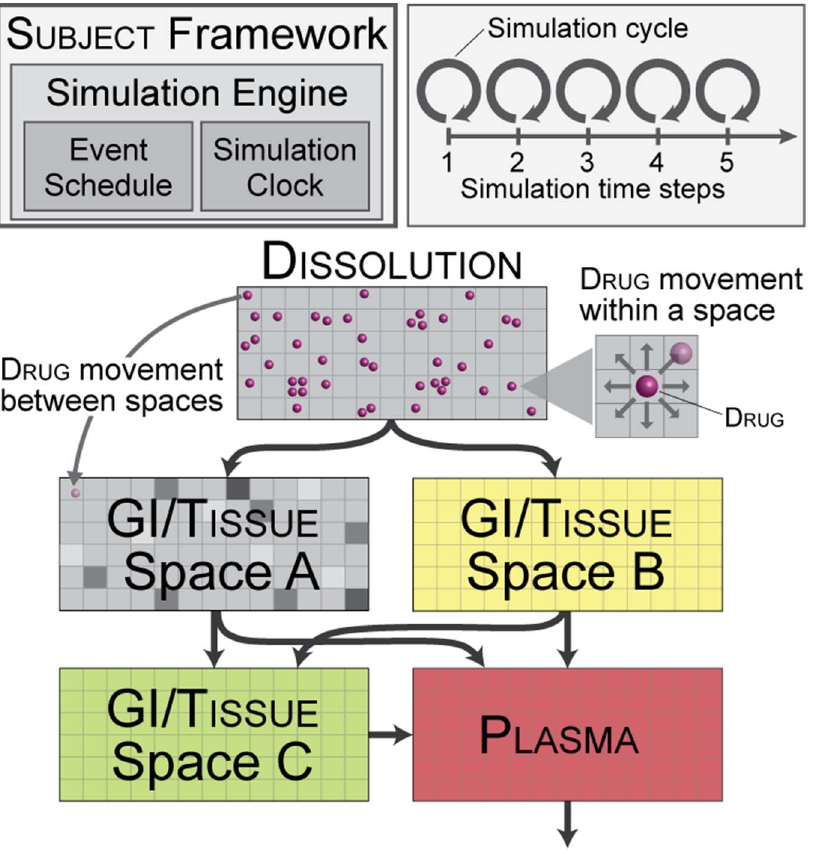
Figure 2. In silico model. The current, validated analog comprises five spaces that map abstractly to the dissolution site, plasma, and GI/tissue features that are hypothesized to impact felodipine disposition. The arrows indicate drug object movement. Drug objects move between interconnected spaces and exit from the plasma grid. Simulated mixing and distribution occurs within each space, which we implemented using a discrete dispersion algorithm. Structural and functional heterogeneity can be introduced at any scale. Spaces shaded differently within a grid (e.g., GI/ tissue space A) indicate that their properties can be customized, should that be needed to represent heterogeneity. Relative to our prior work [5], GI/ tissue spaces A and B map to the GI tract and interaction space, respectively. The in silico model is a discrete event system, i.e., system dynamics emerge as a consequence of events executing at discrete time points. Drug movements within and between spaces are represented as events and scheduled for every simulation cycle. Scheduling of events and simulation time management are handled automatically by a simulation engine (MASON library) instantiated within the framework, which includes an event scheduler and simulation clock.